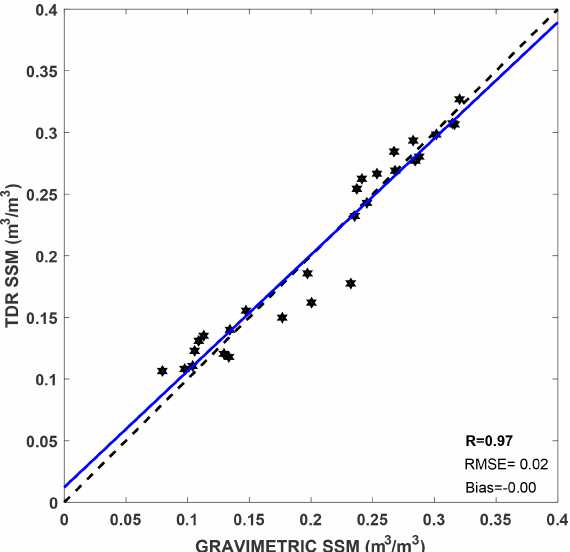
Figure 3. Surface soil moisture measured by TDR versus gravimet- ric measurements using samples collected in both fields F1 and F2 during the 2016/17 growing season. The solid blue line is the linear regression, and the dashed line is Y = X .